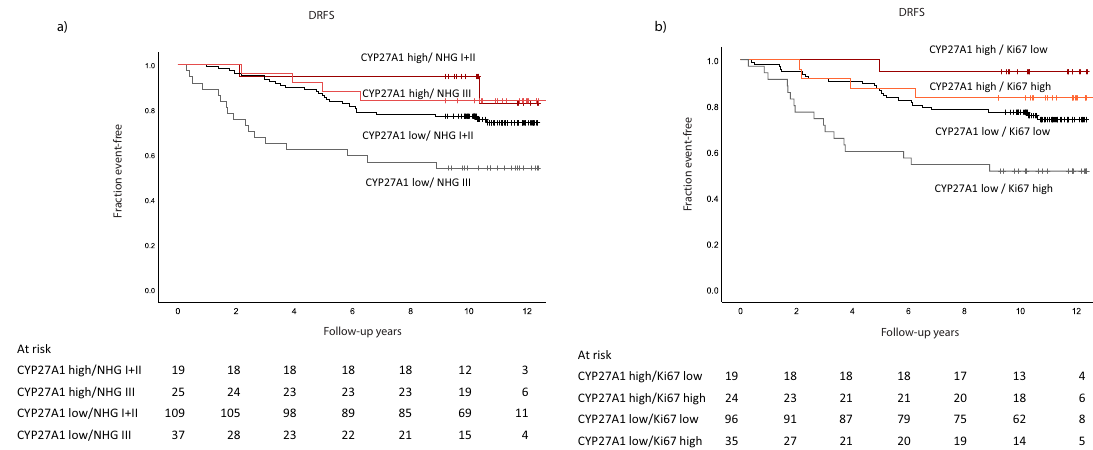
Fig. 3 Kaplan – Meier graphs showing the joint prognostic impact of CYP27A1 expression with NHG and Ki67. a CYP27A1/NHG, b